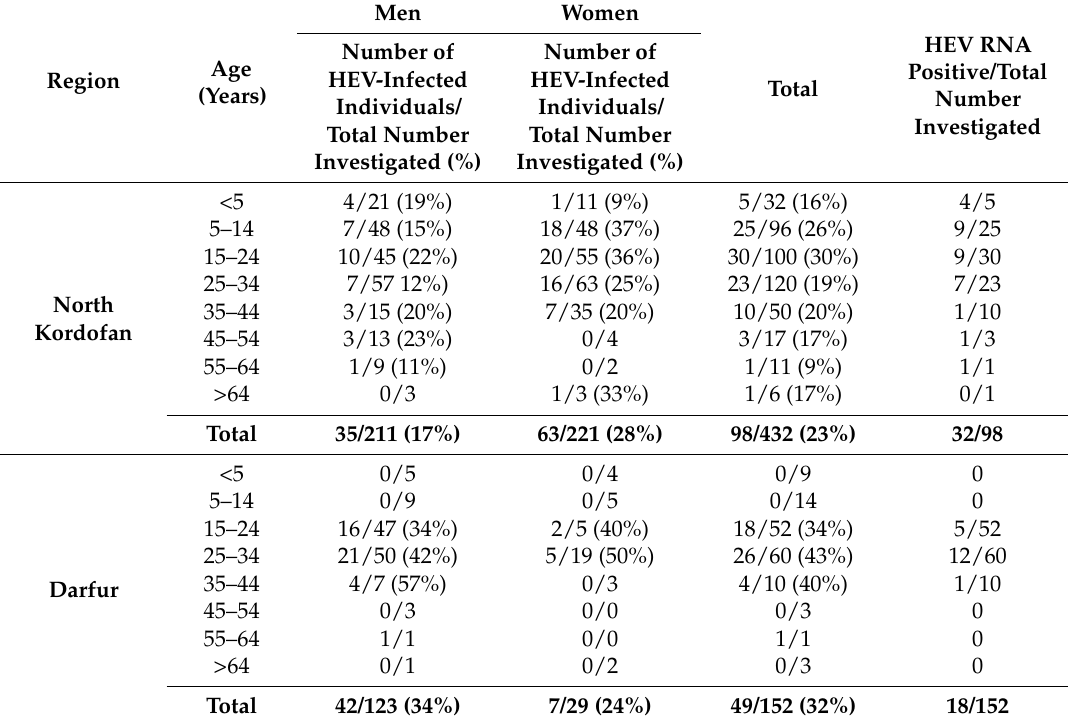
Table 3. Anti-HEV IgM and HEV RNA in relation to age of and number of investigated patients with clinical hepatitis in Kordofan and Darfur during the study